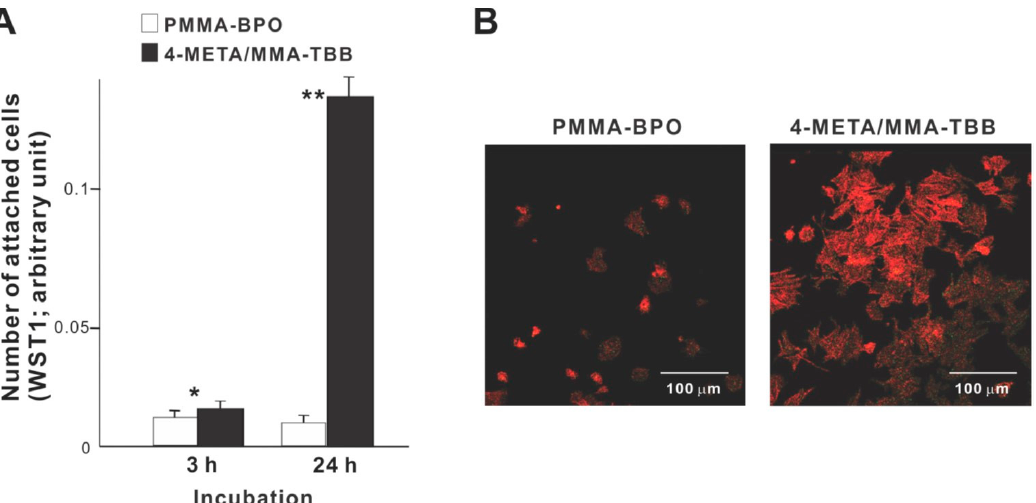
Figure 2. Osteoblast attachment to two di ff erent resinous materials during the initial stage of culture. ( A ) The number of cells attached to material surfaces at 3 h and 24 h post-seeding evaluated by the WST-1 assay. * p < 0.05, ** p < 0.01, statistically significant di ff erence between the two materials. ( B ) Confocal microscopic images of osteoblasts 24 h after seeding on two di ff erent